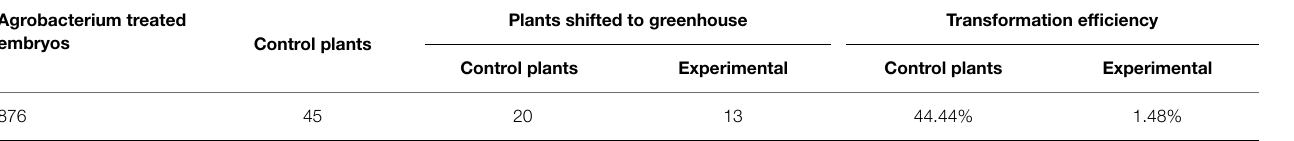
TABLE 3 | Transformation